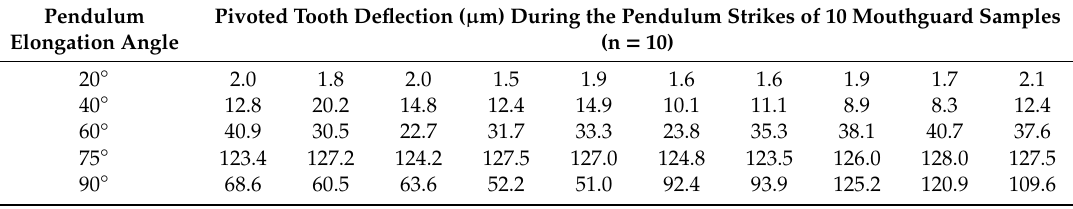
Table 2. BIOPLAST 2 mm mouthguard measurements: Average values of maximum amplitudes (mean of 5 measurements per mouthguard and angle) of the pivoted tooth (reflection foil) deflection obtained during measurements with energy blows from 20 ◦ –90 ◦ pendulum elongation angles.